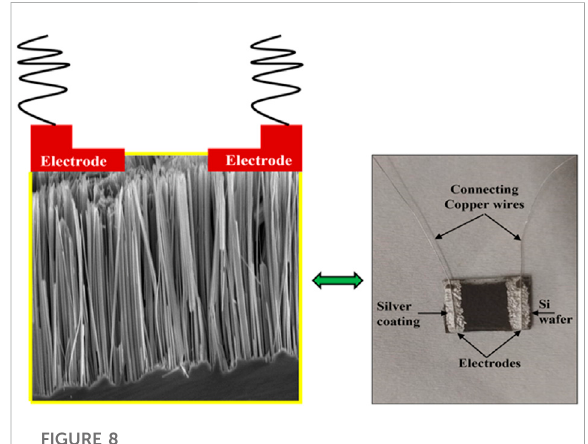
FIGURE 8 Ohmic contacts with Si NWs and electrodes.